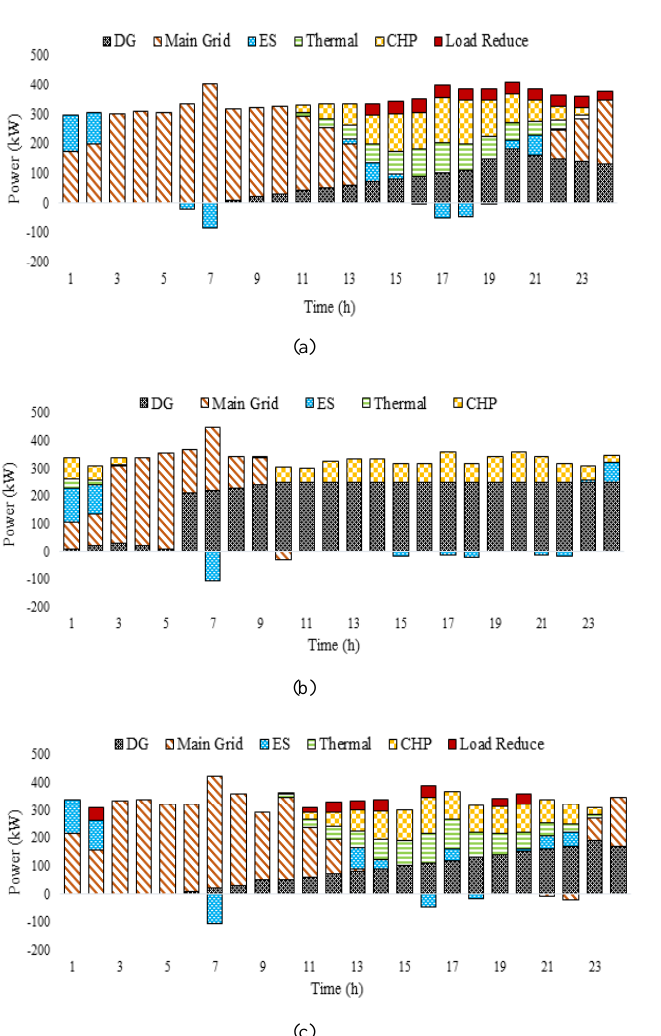
Fig. 6. Generated electrical power of units and the main grid, a) first case; b) second case; c) third case.